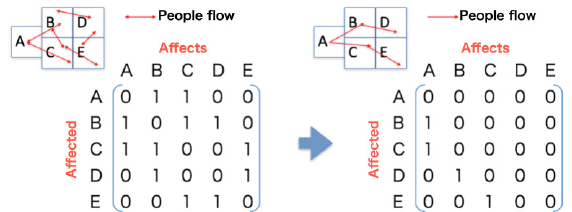
Figure 7. Concept of directed adjacency